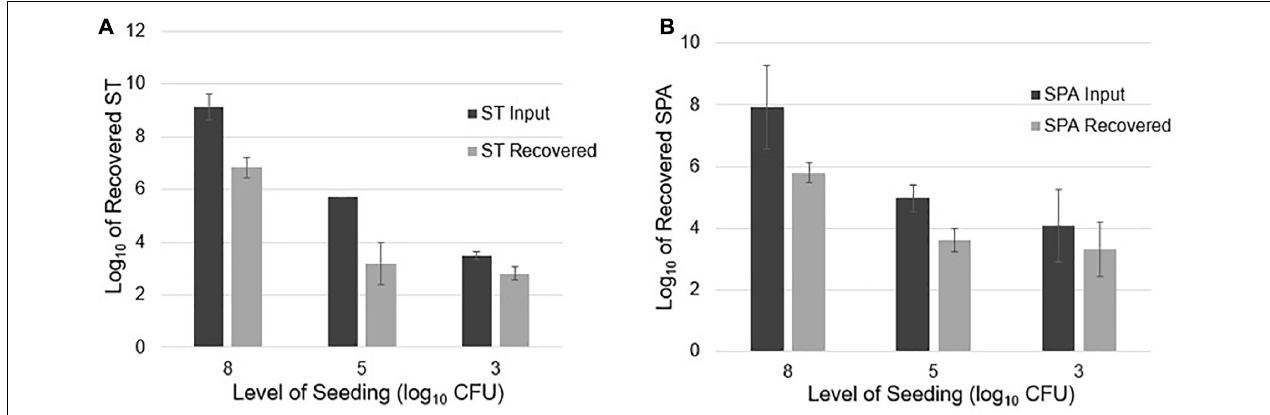
FIGURE 4 | ST and SPA mean recovery at different seeding levels (approximately 8, 5, and 3 log 10 cfu) in 20 L of sewage using the ultrafiltration method in three replicate experiments. The experiments were validated using Salmonella strains from ATCC (ST: 19430; SPA:9150) tested by primers/probes described by Karkey et al. (2016). Error bars represent standard deviation in three replicate experiments. (A) Black bars represent the mean input of ST seeded into the 20 L sewage samples, and gray bars represent the mean recovered ST. (B) Black bars represent the mean amount of SPA seeded into the 20 L sewage samples, and gray bars represent the mean amount of SPA detected by